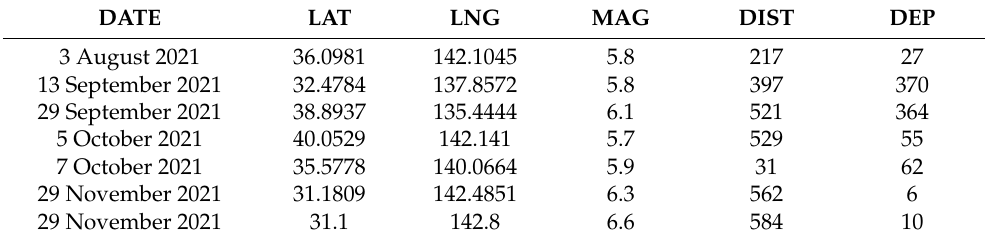
Table 1. The parameters of the EQs shown on the map in Figure